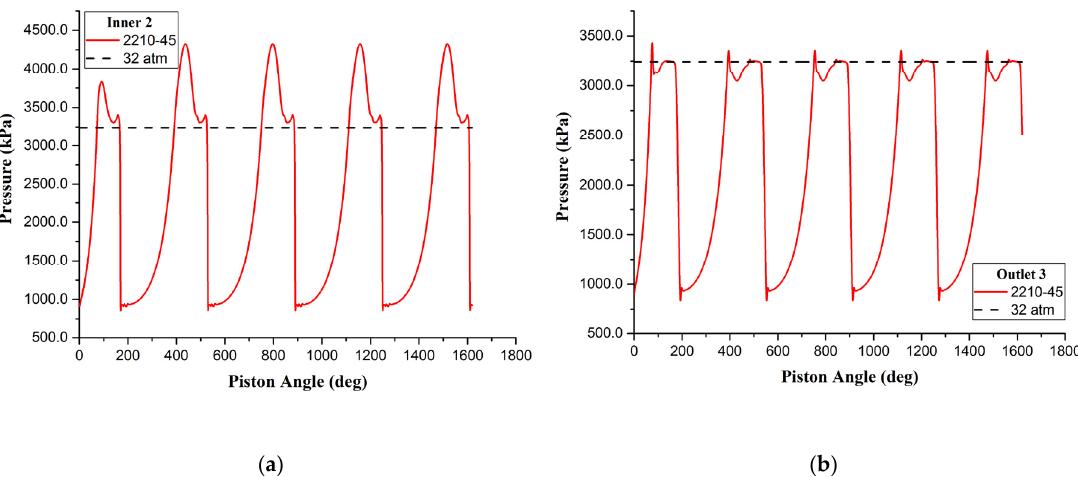
Figure 7. Physical properties of basic type, model 2210-45: ( a ) mass flow rate and pressure at Inlet 1, ( b ) pressure of compression chamber at Inner 2 and opening angle of reed valve, ( c ) discharge mass flow rate and pressure at Outlet 3.